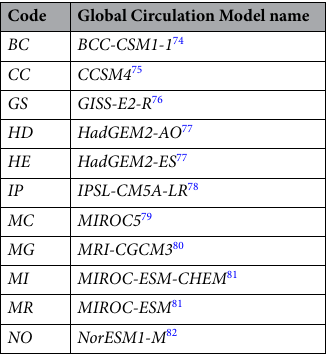
Table 1. Names of the Global Circulation Models used to make future projections and their